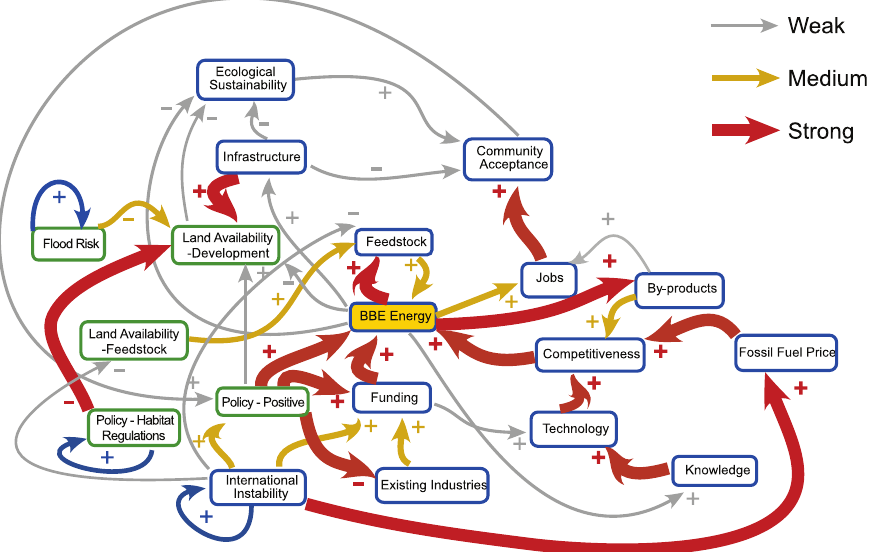
Figure 5. Modified FCM from the Humber Environmental Managers’ Meeting showing the non-local feedstock scenario. Thickness of the links denotes the strength of the